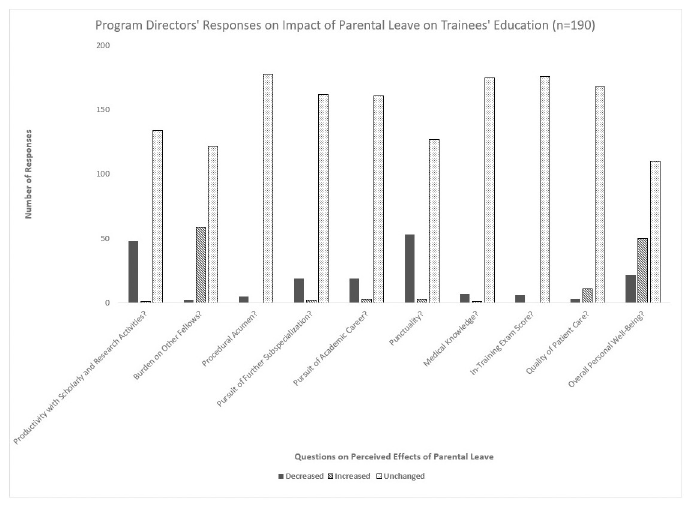
Fig 3. Program directors’ responses on parental leave impact on trainees’